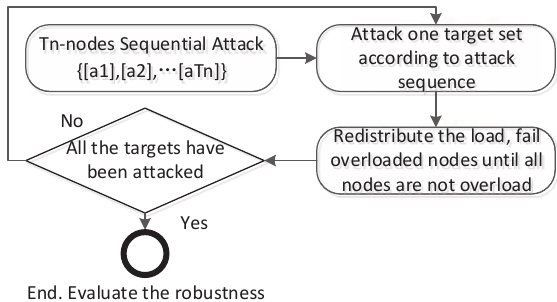
Figure 3. Flow chart of the sequential attack process in a load-induced Cyber-Physical